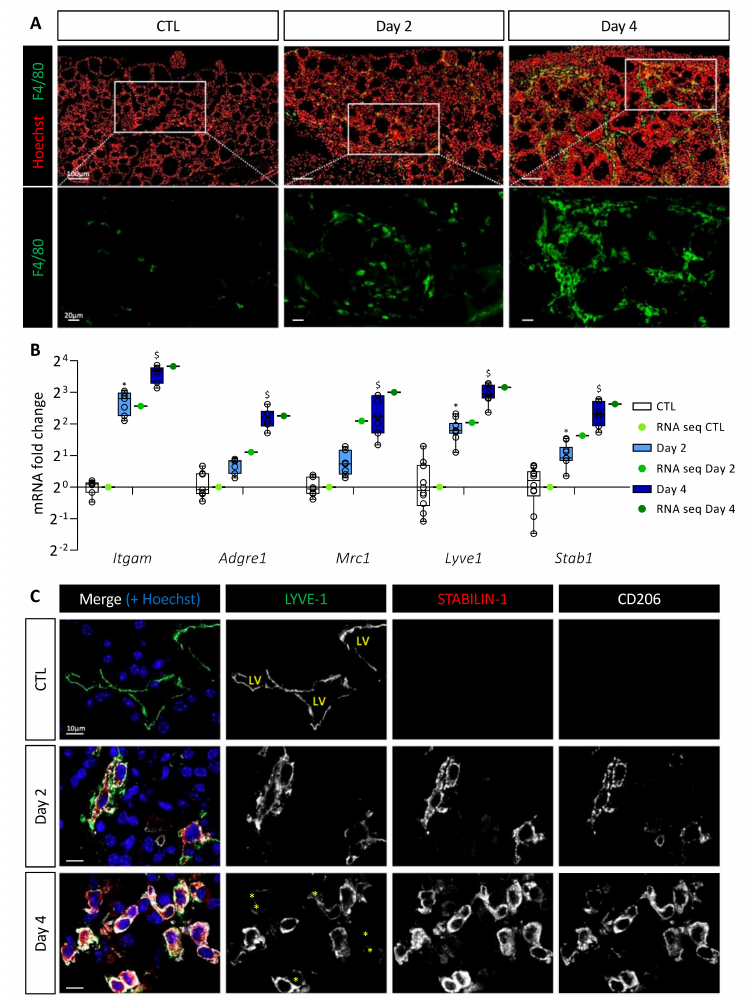
Figure 2. BRAF V600E expression in mouse thyrocytes leads to massive macrophage recruitment including a particular macrophage population characterized by LYVE-1, CD206, and STABILIN-1 expression. ( A ) Immunohistofluorescence of F4/80 (green) on thyroid tissues from control (CTL) and doxycycline- treated mice (Day 2, Day 4). Hoechst (red) is used to label the nuclei. ( B ) mRNA fold change of different macrophage markers found in RNA sequencing data (green dots) and measured by RT-qPCR (white and blue boxes) from CTL ( n = 10) and doxycycline-treated mice, after 2 ( n = 11) and 4 days ( n = 7) of injections (Day 2, Day 4). mRNA fold changes are normalized to the geometric mean of Rpl27 and Gapdh expression and compared to control group. Data are expressed as the mean ± SD (* p < 0.05, $ p < 0.001). ( C ) Immunohistofluorescence of LYVE-1 (green), STABILIN-1 (red), and CD206 (white) on thyroids from control (CTL) and doxycycline-treated mice (Day 2, Day 4). Hoechst (blue) is used to label the nuclei. LV indicates the lumen of lymphatic vessels, and yellow asterisks denote cells with a very weak signal for LYVE-1 but positive for STABILIN-1 and CD206